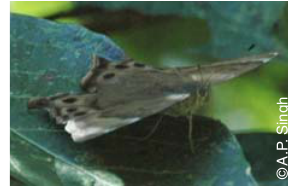
Image 94. Large Goldenfork, Zophoessa goalpara (upper)